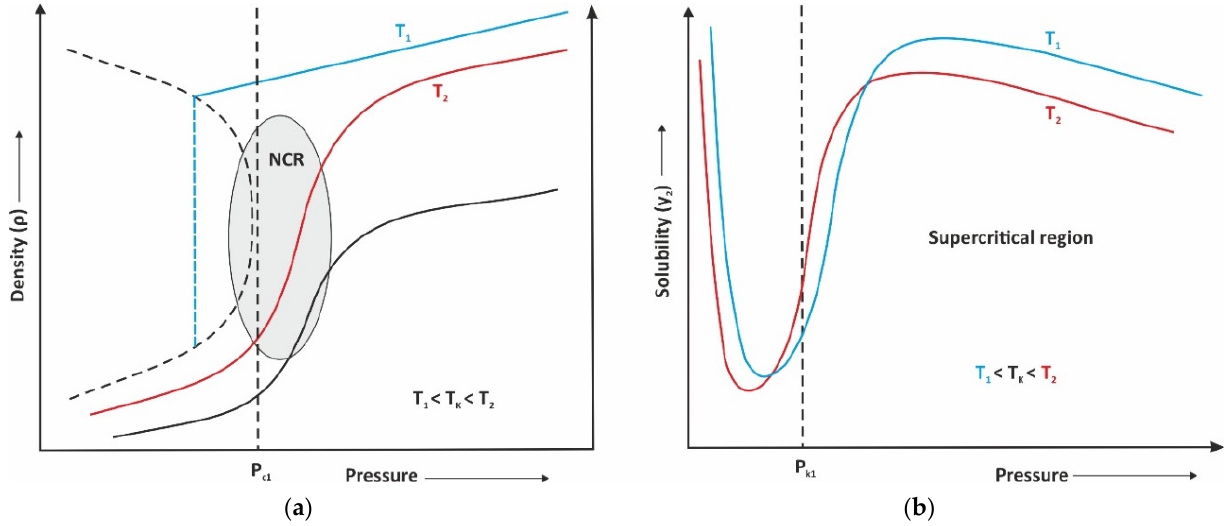
Figure 2. The interconnection between the ( a ) density and ( b ) solubility by increasing the pressure.